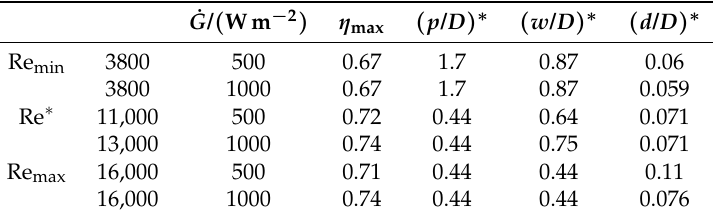
Table 13. Maximum efficiency and optimum roughness parameters according to the model developed by Chauhan and Thakur